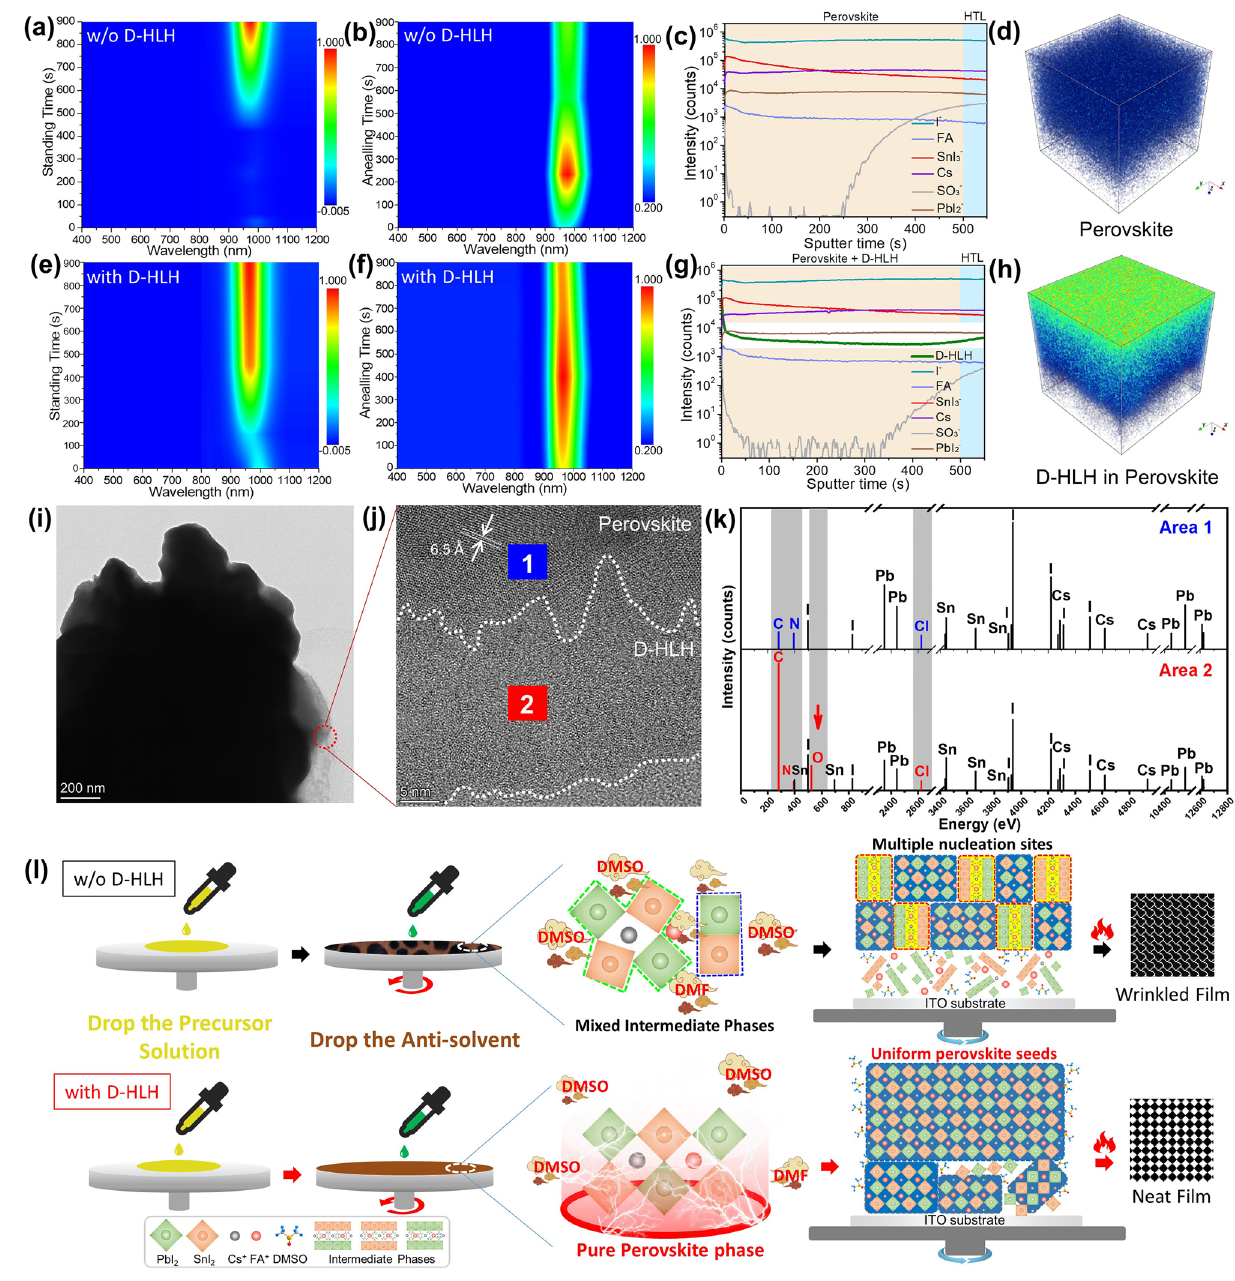
Fig. 3 In situ PL spectral data of intermediate phase films prepared a, b without and e, f with D‑HLH, after various a, e standing and b, f annealing times. c, g ToF–SIMS depth profiles and d, h 3D profiles of the perovskite films prepared c, d without and g, h with D‑HLH. i TEM image of the perovskite prepared with D‑HLH. j HRTEM image of the circled region in ( i ). k EDS spectra of the blue and red boxed regions in ( j ). l Schematic representation of the effects of D‑HLH on the regulation of the nucleation process and on the improvement in crystalline